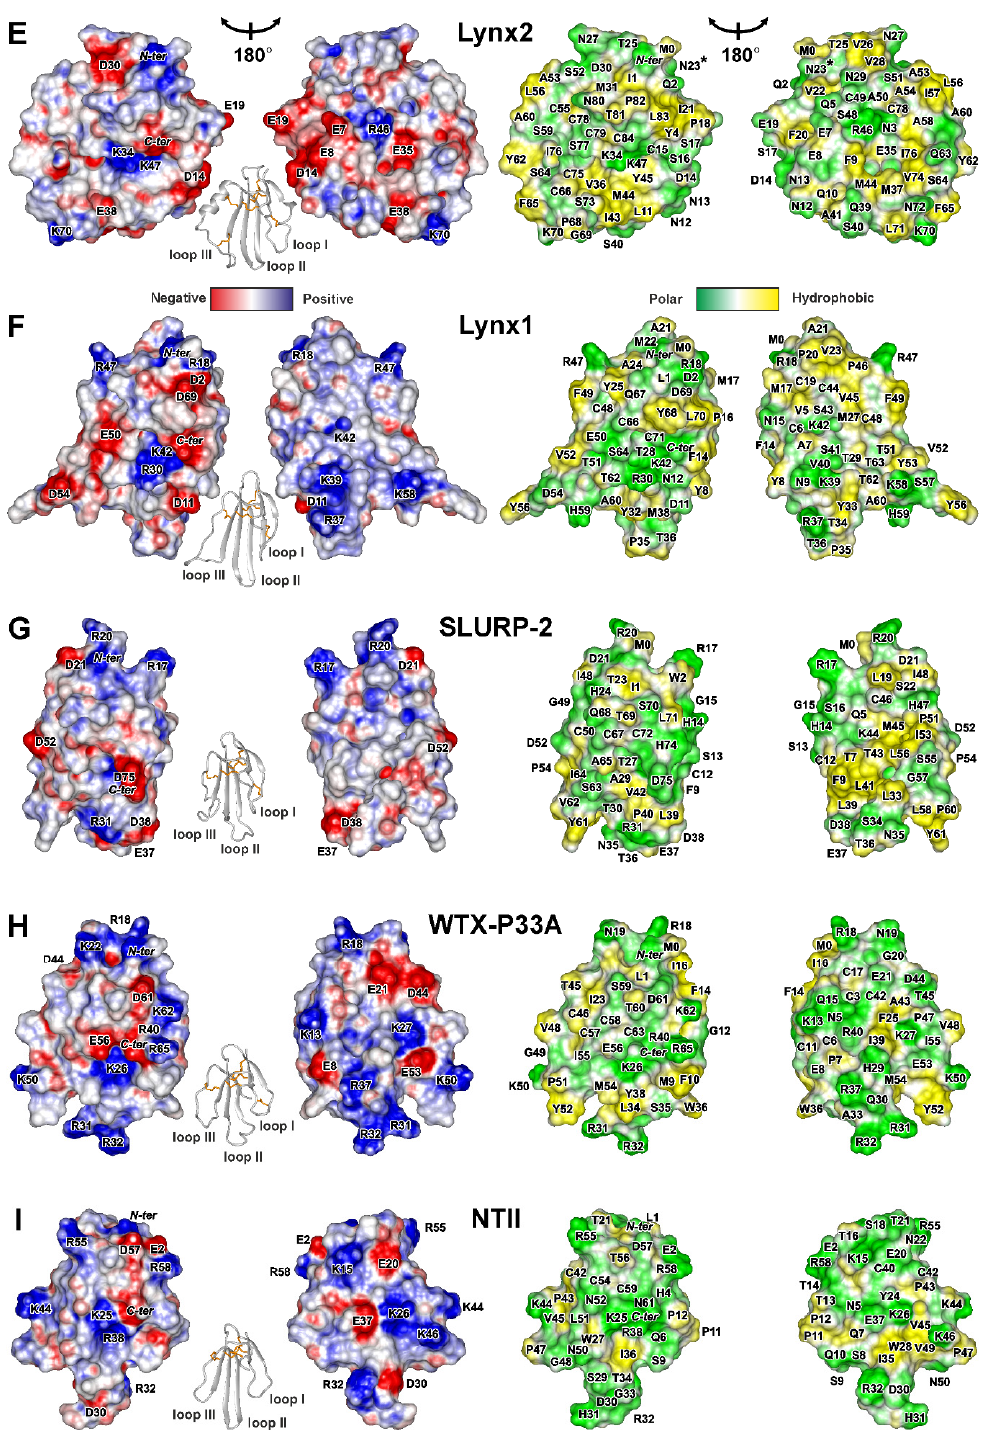
Figure 4. Two-sided view of molecular surfaces of TFPs: ( A ) trans -Tyr39-Pro40 SLURP-1, ( B ) cis -Tyr39-Pro40 SLURP-1, ( C ) Lypd6, ( D ) Lypd6b, ( E ) Lynx2, ( F ) Lynx1, ( G ) SLURP-2, ( H ) WTX-P33A, ( I ) NTII. Electrostatic and molecular hydrophobicity [67] potentials are shown. Red, blue, green, and yellow areas denote negative, positive, polar, and hydrophobic regions, respectively. The ribbon representation shown for each protein / isomer corresponds to the left panel. The predicted glycosylation site (Asn23) in the Lynx2 molecule is shown by